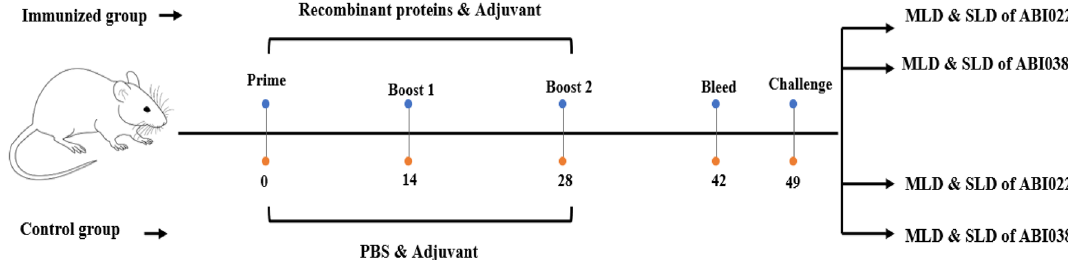
Figure 4. Flow chart of immunization and challenge schedules. Mice received three immunization doses with the 40 µg of combination of proteins (10 µg of FimA + 10 µg of CsuA/B + 10 µg of HemTR + 10 µg of BauA/each) mixed with adjuvants at two weeks intervals. Antibody responses were measured using blood sera from mice on day 42. Mice were challenged with MLD and SLD of A. baumannii strains on day 49.